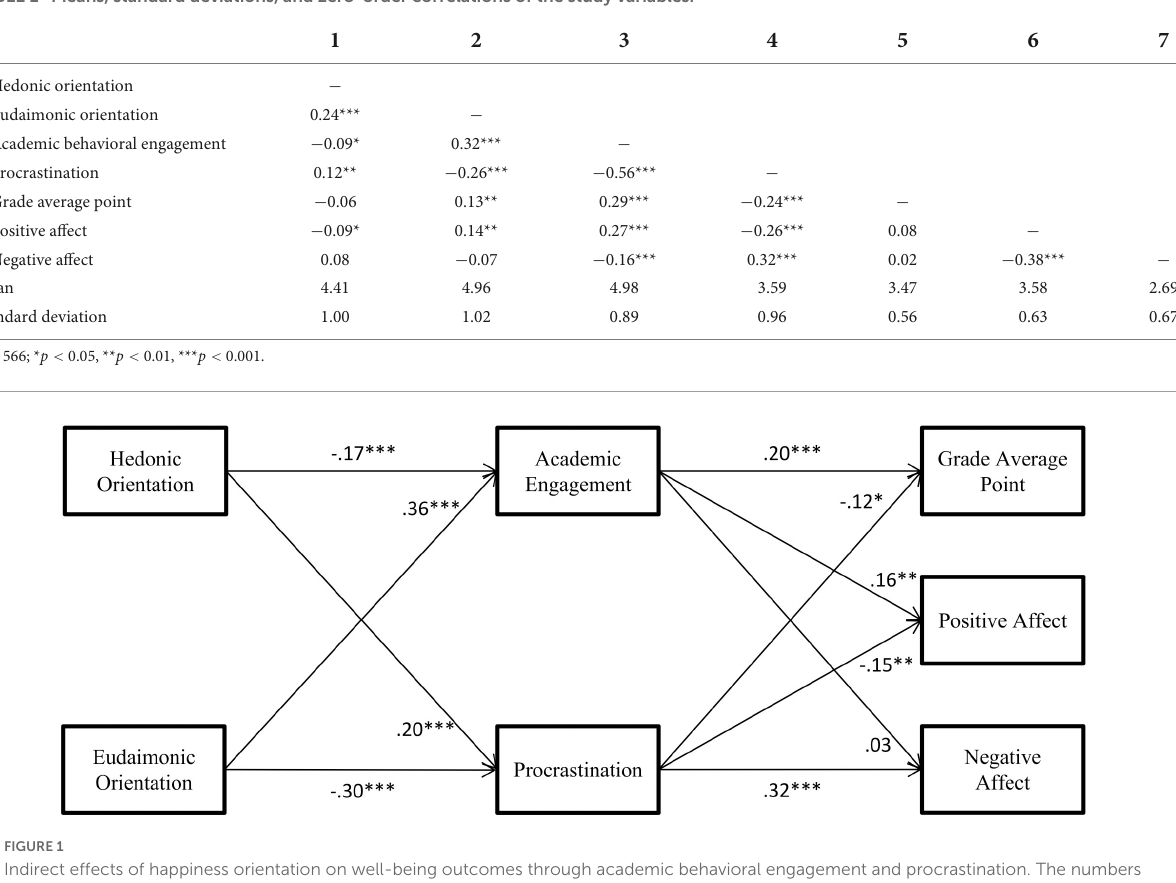
TABLE 1 Means, standard deviations, and zero-order correlations of the study variables.